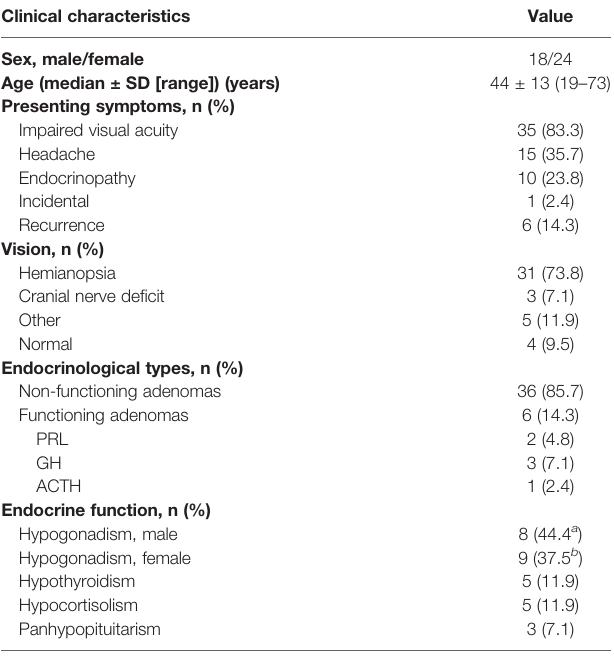
TABLE 1 | Clinical characteristics of 42 patients with large to giant pituitary adenomas in Knosp grade 4. Clinical characteristics